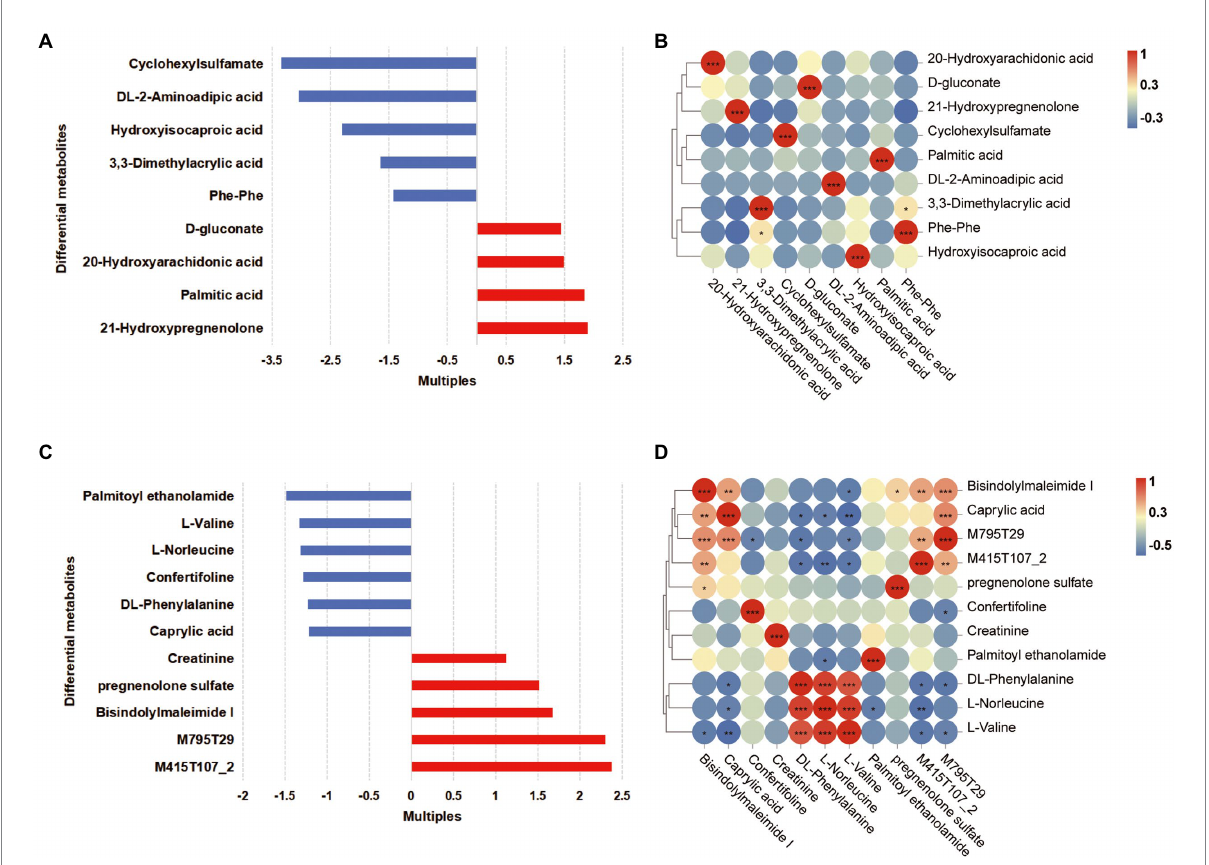
FIGURE 3 Differential metabolites in the fecal and plasma samples of women in full-term pregnancy. (A) The fold changes of differential metabolites in the fecal samples. Each bar colored by the red and blue indicates increase and reduction, respectively. (B) The correlation heatmap of fecal metabolites. (C) The fold changes of differential metabolites in the plasma samples. Each bar colored by the red and blue indicates increase and reduction, respectively. (D) The correlation heatmap of plasma metabolites. * p < 0.05; **0.001 ≤ p < 0.01; *** p <